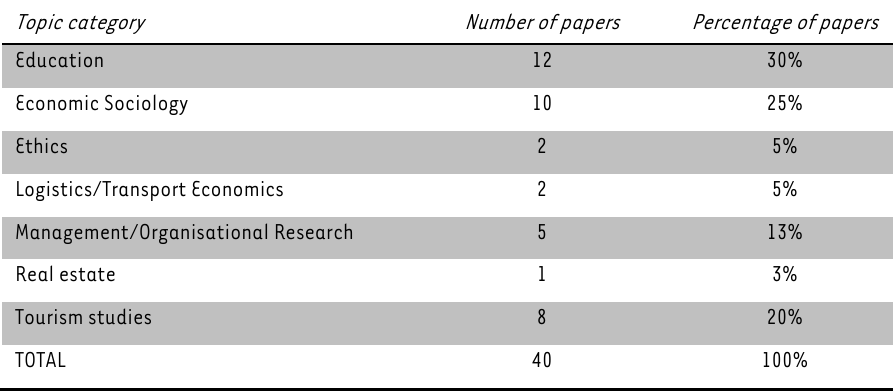
TABLE 11: Sub- categorisation of papers classified as ‘Other’ Topic